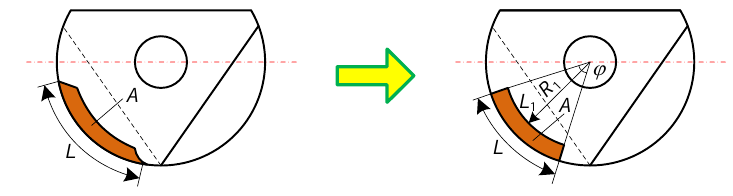
Figure 17. A simplified model of the tool–chip contact area.